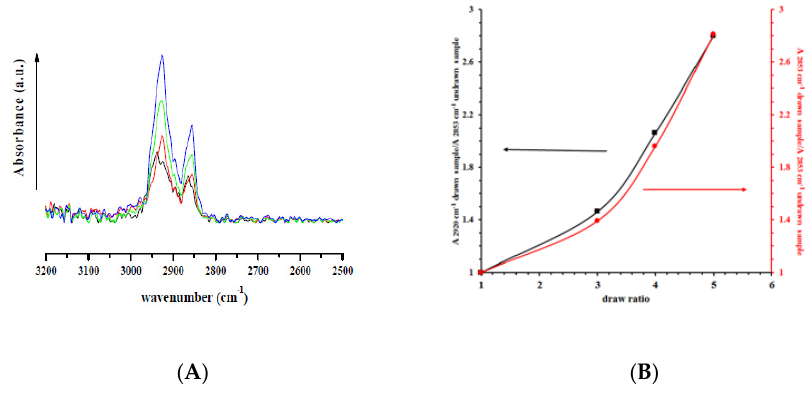
( A ) ( B ) Figure 3. ATR spectra of ( A ): Undeformed nanocomposite ( ), drawn at λ = 3 ( ), drawn at λ = 4 ( ), and drawn at λ = 5 ( ); and ( B ) the ratio between absorbance bands of symmetrical (2850 cm − 1 ) and asymmetrical (2930 cm − 1 ) C–H stretching for drawn samples divided by the absorbance of undrawn samples.